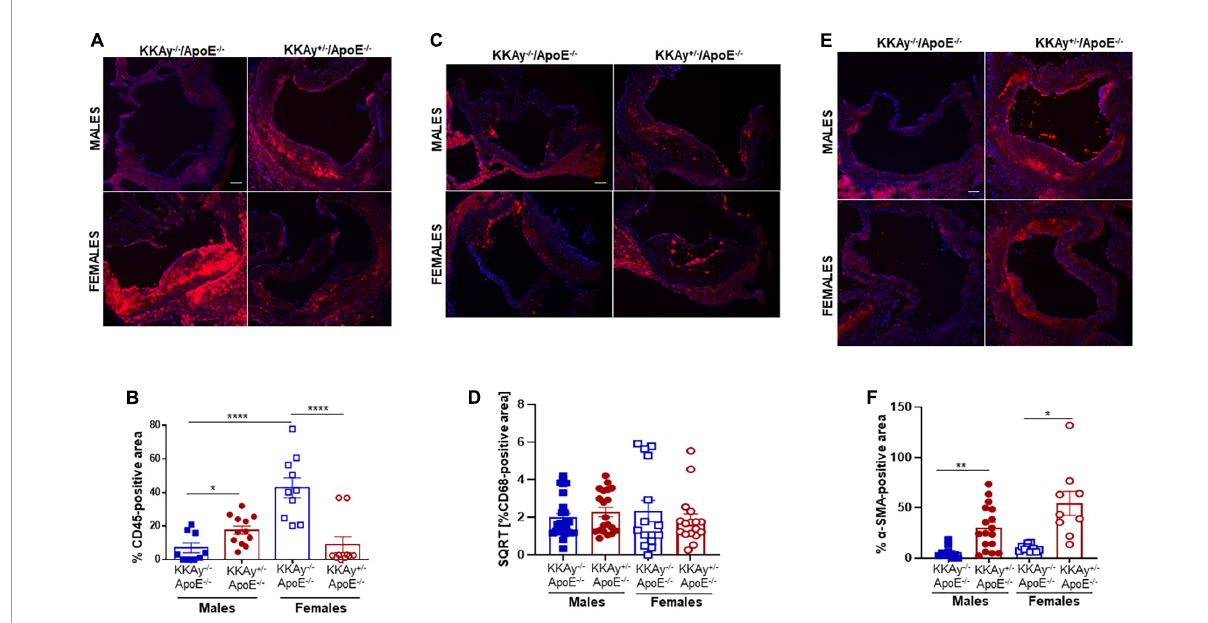
FIGURE4 Leukocyte and macrophage infiltration and SMC content in aortic root lesions of MetS KKAy + / − ApoE − / − and non-MetS KKAy − / − ApoE − / − mice. Aortic root sections were subjected to immunohistochemistry using CD45, CD68, and α -SMA antibodies. Images were taken at 10x magnification. Total lesion area and positive staining area of lesions (in sq. pixels) were quantified in each section using Image J. Shown are (A) representative images for CD45 staining (leukocyte content), (B) summary graph for %CD45-positive area, (C) representative images for CD68 staining (macrophage content), (D) summary graph for %CD68-positive area, (E) representative images for α -SMA staining (SMC content), and (F) summary graph for %SMA-positive area ( n = 5–6 mice per genotype per sex (2–4 sections per mouse). All values are expressed as mean ± SEM; * p < 0.05, ** p < 0.005, **** p < 0.0001, scale bar = 115 µ